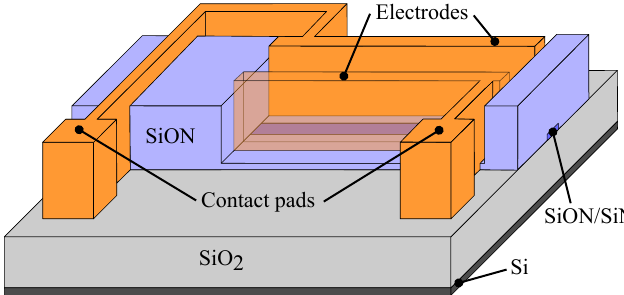
Figure 3. Refractive index matched SiON cladding, which reduces transition losses between poled and non-poled areas and can also be used as bridges over the waveguides in order to connect the electrodes with the contact